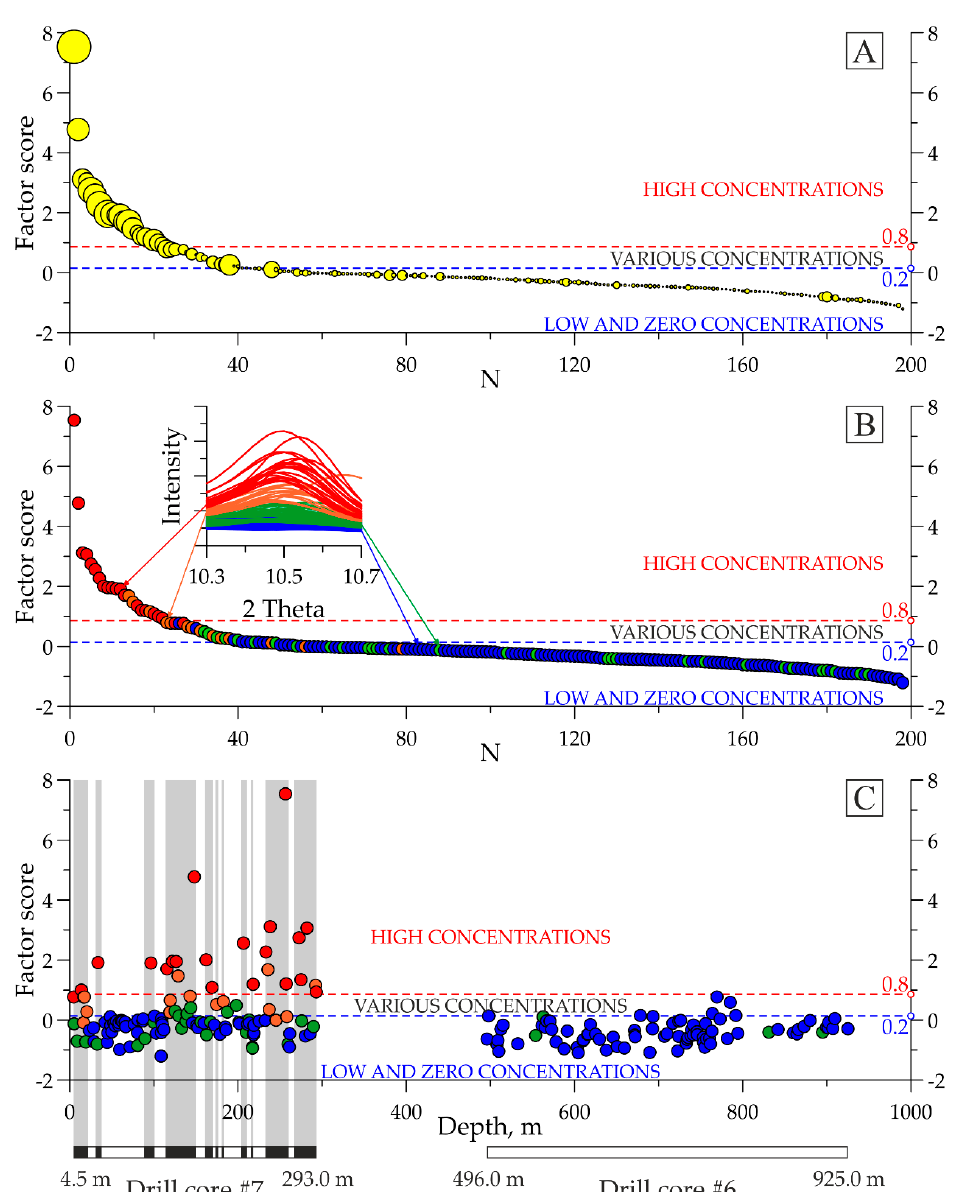
Figure 5. ( A , B ) The ranked range of the amphibole FS s. In ( A ), the point diameters are proportional to the semiquantitative estimates of amphibole abundance. In ( B ), the coloration of the figurative points reflects the division of the collection into four groups, according to the amphibole content in the samples: red, maximum content; orange, high content; green, low content; blue, no amphibole (detailed explanations are in the text). The inset shows the amphibole peak, which served as determinant for referring to the groups. ( C ) The distribution of the amphibole FS s in sections of the studied cores.